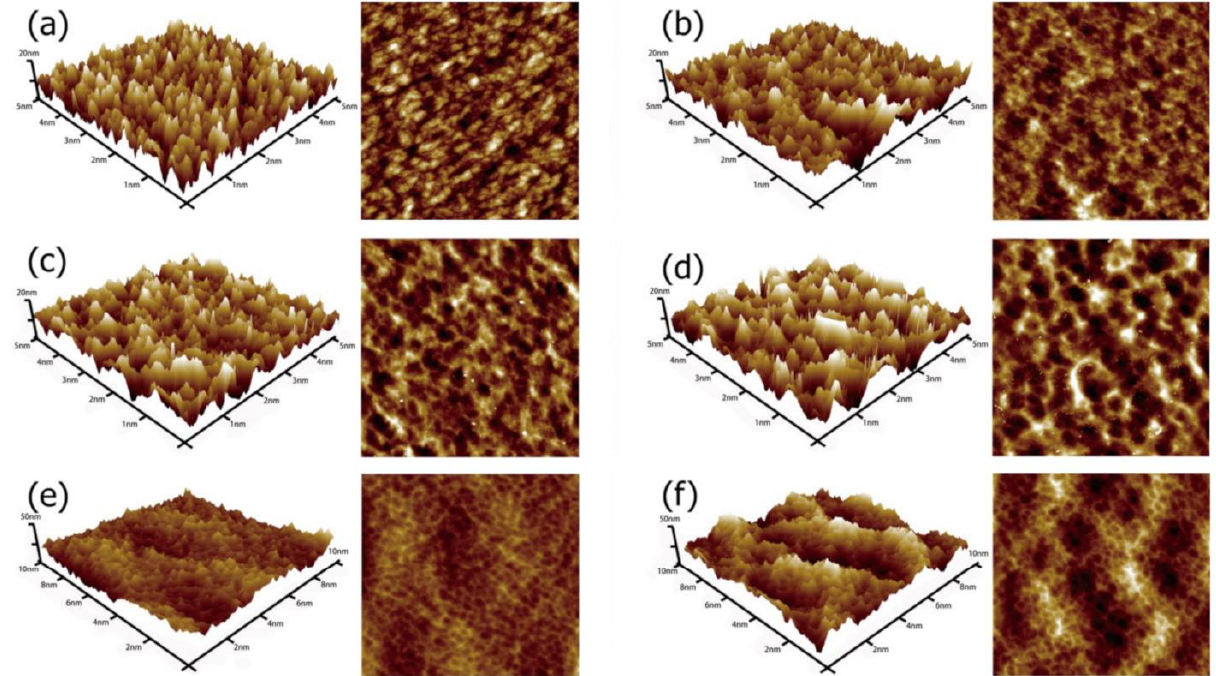
Figure 6. 3D and 2D diagrams of (TiCrV)x-(TaW)1-x (A-M) binary system HEA films: ( a ) Sample B, ( b ) Sample D; ( c ) Sample F; ( d ) Sample H; ( e ) Sample J; and ( f ) Sample L. The surface topography of each group of samples was collected by AFM, and the roughness was calculated. The results are shown in Figure 7. When x < 0.66, the roughness of the coating was relatively low, and the average roughness was Ra < 7.0. Subsequently, as the value of x increased, the roughness rapidly rose and eventually stabilizes, which was roughly maintained at 12.0–13.5.